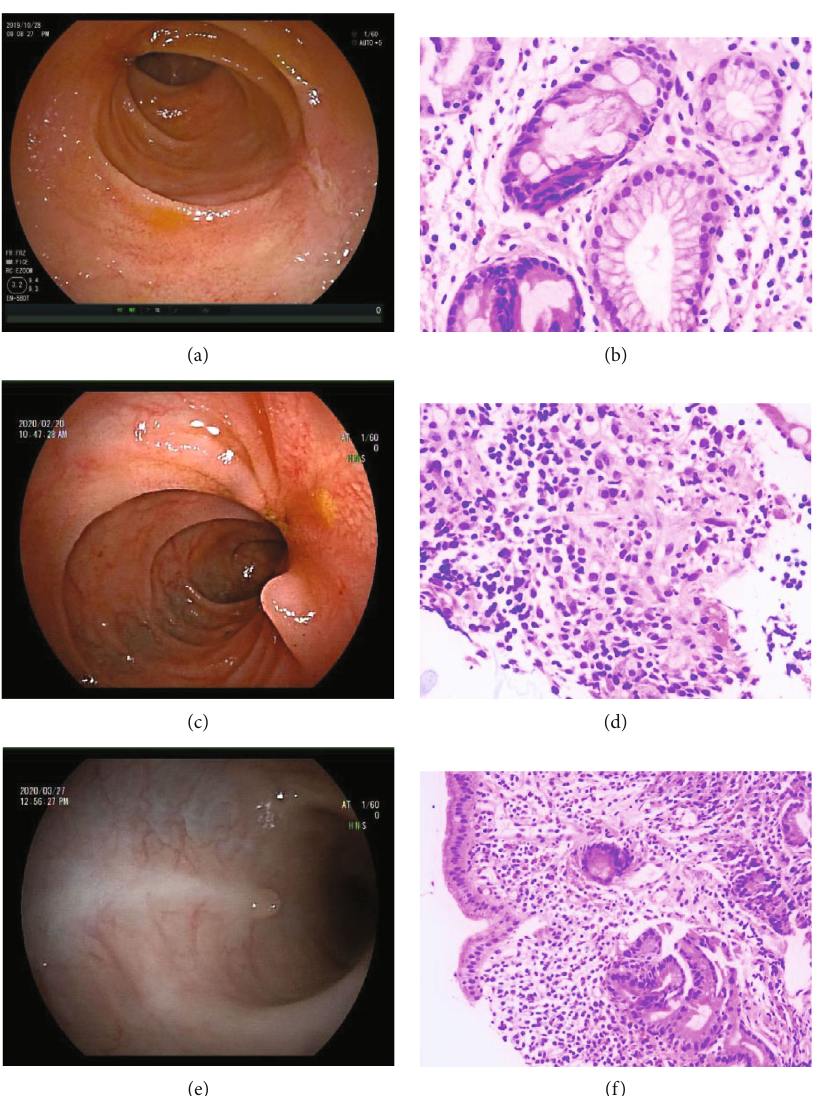
Figure 2: Double-balloon enteroscopy and histopathology (HE staining) of patients with isolated small bowel Crohn ’ s disease. (a) Multiple longitudinal ulcers. (b) Pseudopyloric glandular metaplasia in the terminal ileum ( × 400 magni fi cation). (c) Longitudinal ulcer with luminal stenosis. (d) Noncaseating necrotizing granuloma ( × 400 magni fi cation). (e) Longitudinal ulcer scar with mucosal hyperplasia. (f) Villus atrophy of the small bowel ( × 200 magni fi